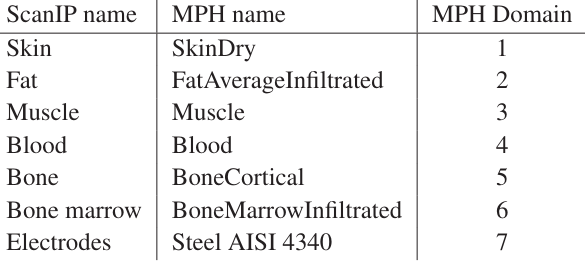
Tab. 1: Tissue mapping table for mapping data between the ScanIP mesh and MPH.